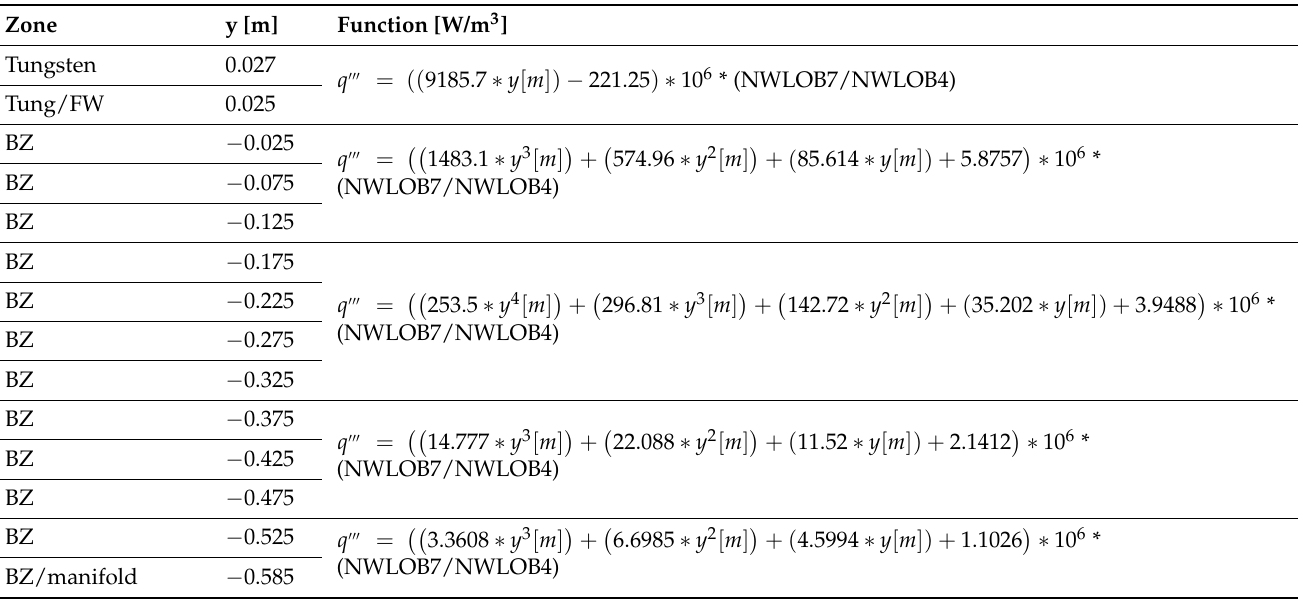
Table A1. Tungsten/Eurofer volumetric power deposition curves scaled for the bottom elementary cell (OB7).